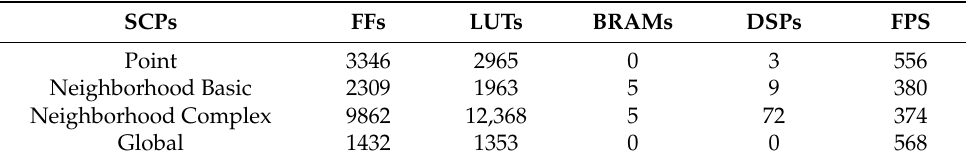
Table 2. SCP utilization and performance (in Maximum Performance